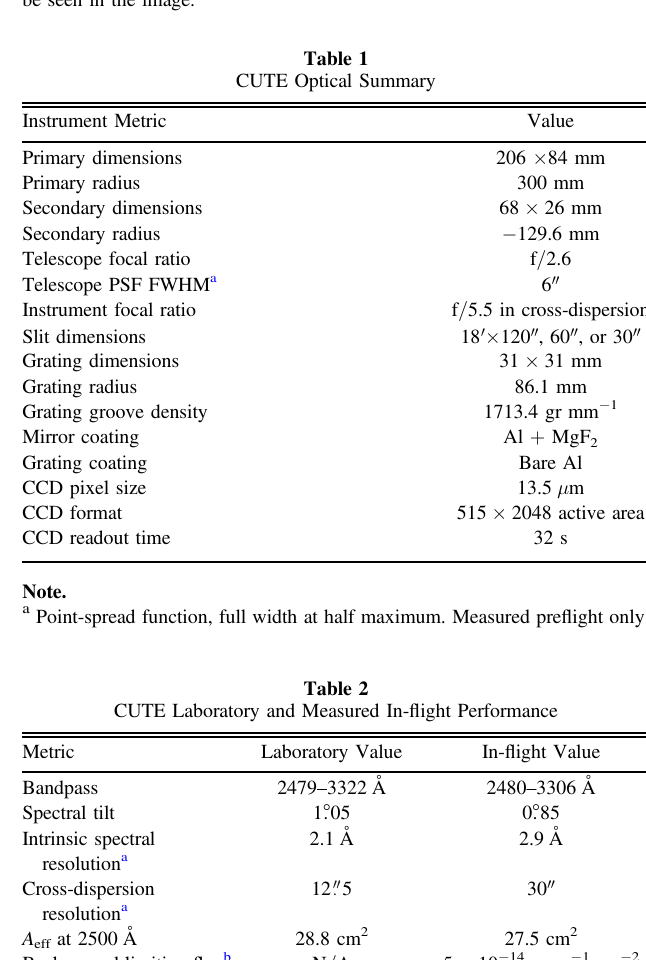
Figure 3. A 2048 × 515 CUTE CCD image with the slit fully illuminated with a diffuse, uncollimated Hg light source, obtained during thermal vacuum testing. The projected image of the slit is shown at several mercury lines, including 2536 Å , 2967 Å , and a doublet at 3125 and 3131 Å . The exposure time for this image was set to sample the fainter spectral features of the light source; as a result, many pixels in the 2536 Å line reached saturation levels and some side effects of this saturation can be seen in the